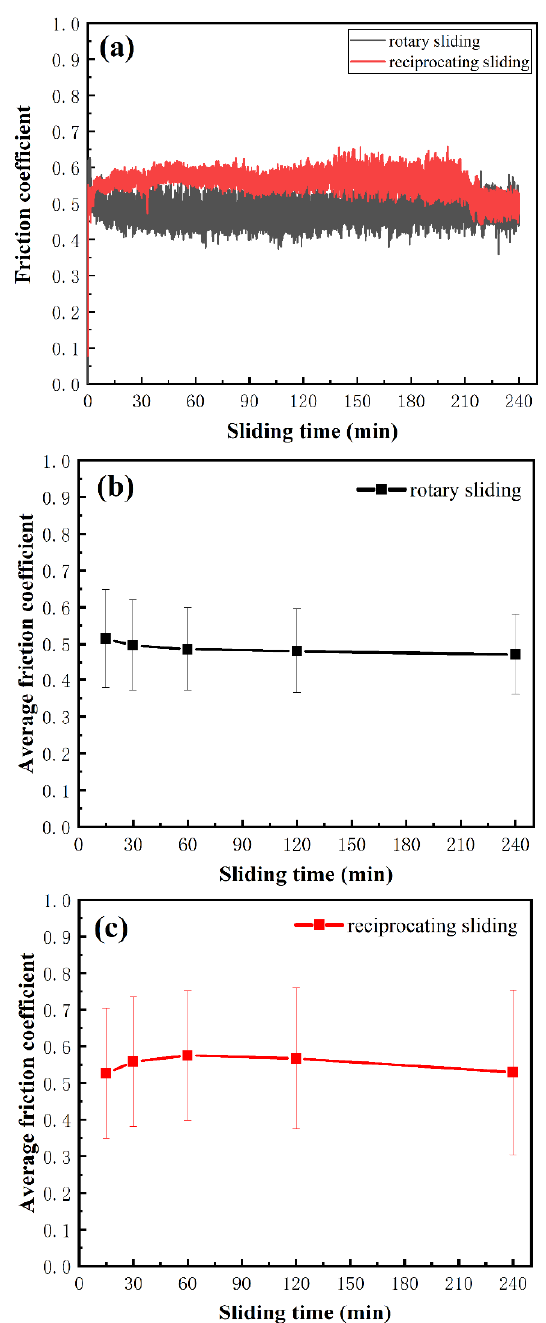
Figure 2. The variation of friction coefficient with the sliding time under rotary sliding and reciprocating sliding modes ( a ); the average friction coefficient with error bars for rotary sliding ( b ) and reciprocating sliding ( c ).